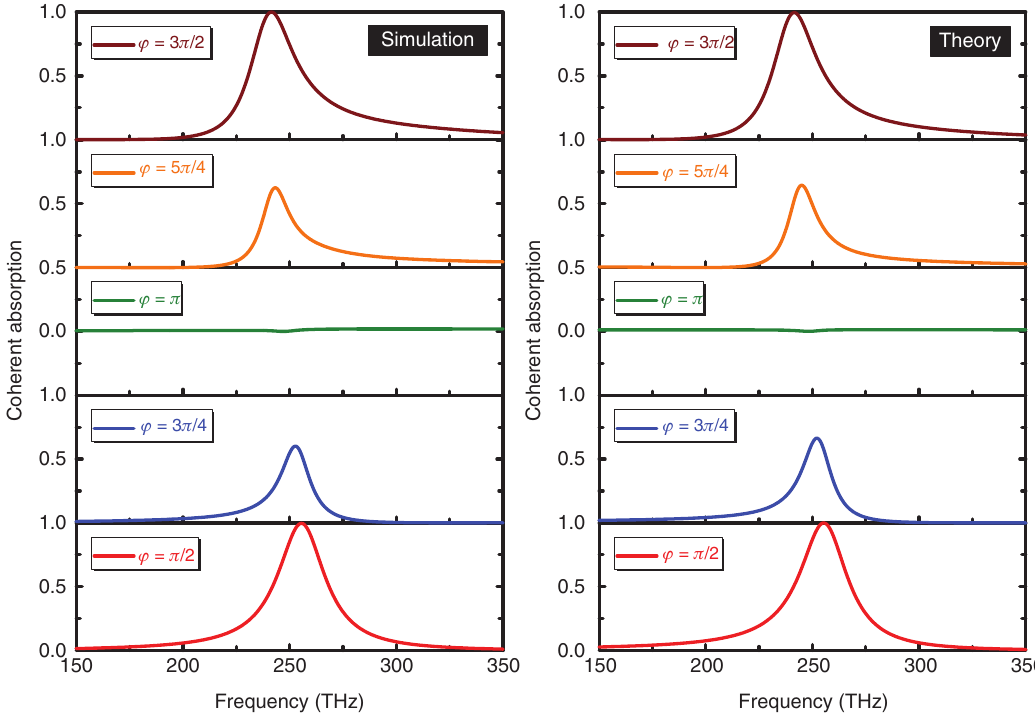
Figure 5: The spectrum of PC-CA of the designed optical system possessing the phase coupling as a function of the phase coupling ϕ for symmetric incidence. The left and right columns respectively show simulation and theoretical